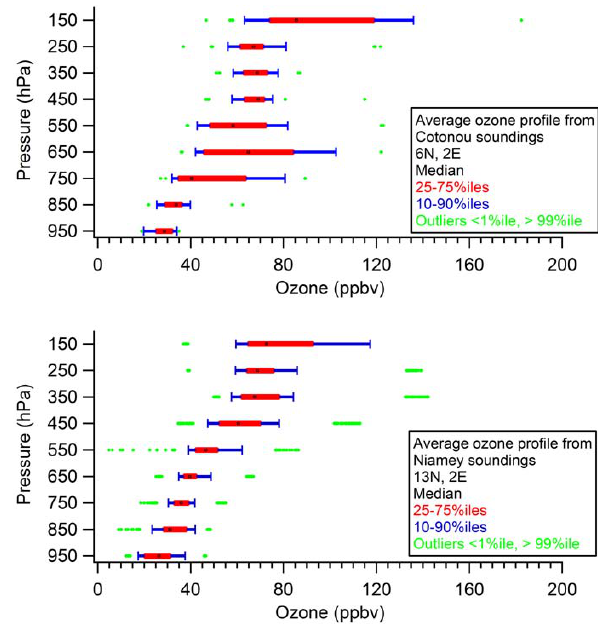
Fig. 11. Average ozone profiles based on (top) 9 soundings from Cotonou (6 ◦ N, 2 ◦ E) launched at 10:00 or 11:00a.m. local time between 21 July and 22 August 2006 and (bottom) 29 soundings from Niamey (13 ◦ N 2 ◦ E) between 26 July and 25 August 2006. The black marker is the median, the red box the range of the 25 to 75 percentiles, the blue whiskers the range of the 10 to 90 percentiles and the green markers are less than the 1 percentile and greater than the 99